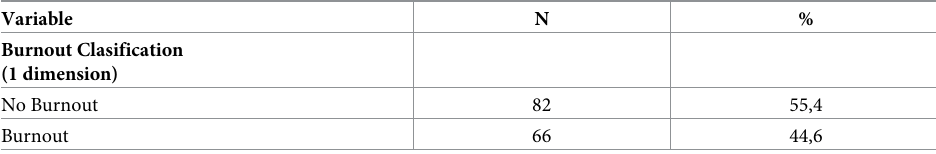
Table 3. Presence of burnout in professionals. Ceara´, Brazil,